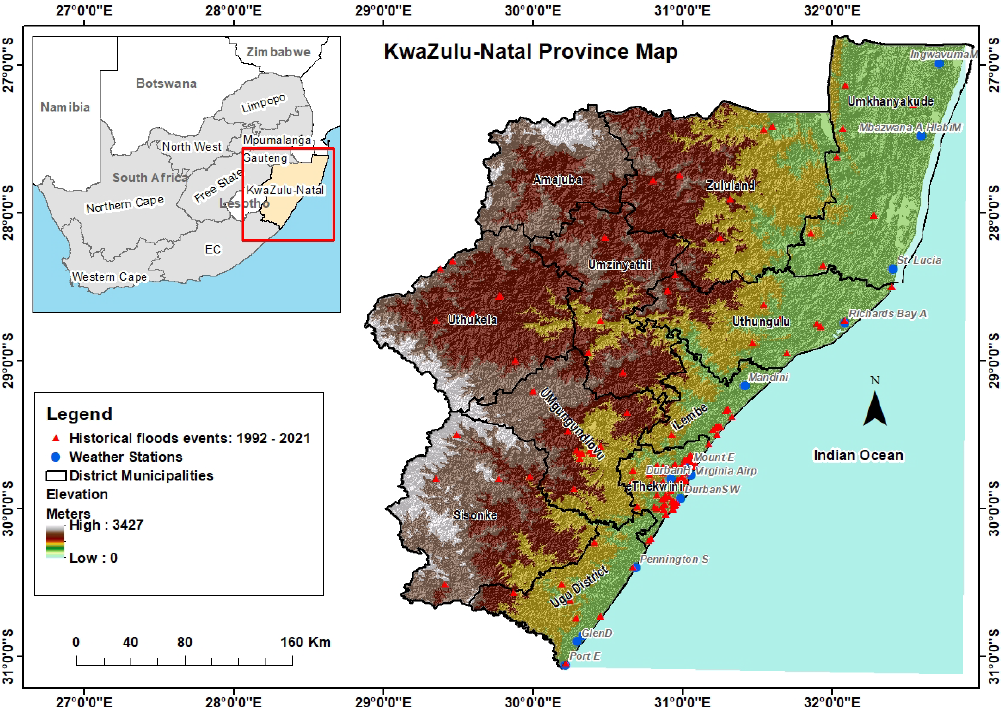
Figure 1. The location of South Africa and the topography of the eastern KwaZulu-Natal Province.